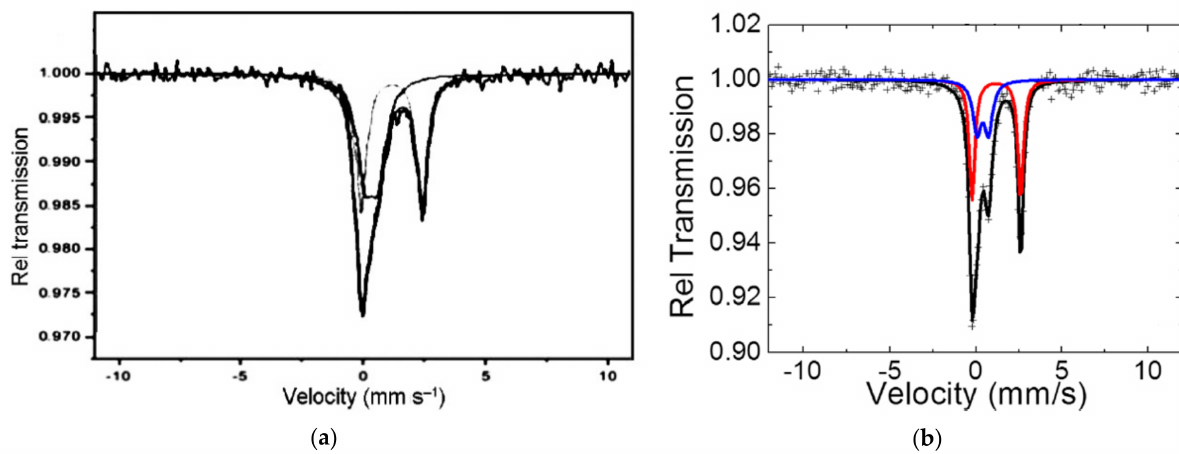
Figure 5. Mössbauer spectra of carbonaceous chondrite Mukundpura CM2 measured at room temperature ( a ) and at 100 K ( b ). Indicated components are the results of the fits. Adapted from References [44,45], respectively.